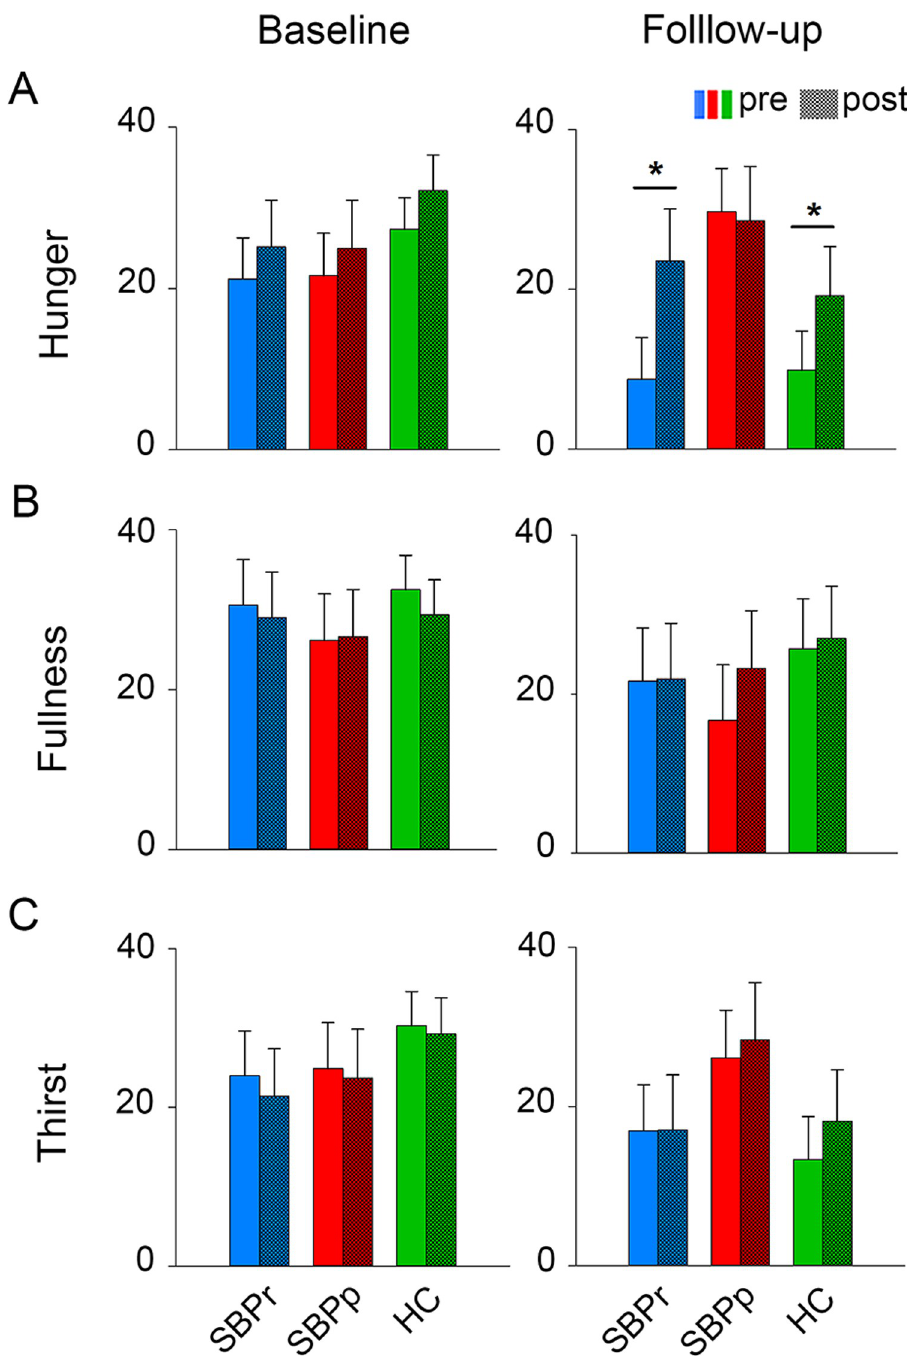
Fig 2. Internal state ratings before and after session 1. ( A ) Hunger, ( B ) Fullness, and ( C ) Thirst rated by SBPr, SBPp and HC (baseline, left; follow-up, right). There were no time and groups effects in any of the other analyses. Abbreviations : SBPr , recovered subacute back pain patients; SBPp , persistent subacute back pain patients; HC , Healthy Control . � , p < 0.05.